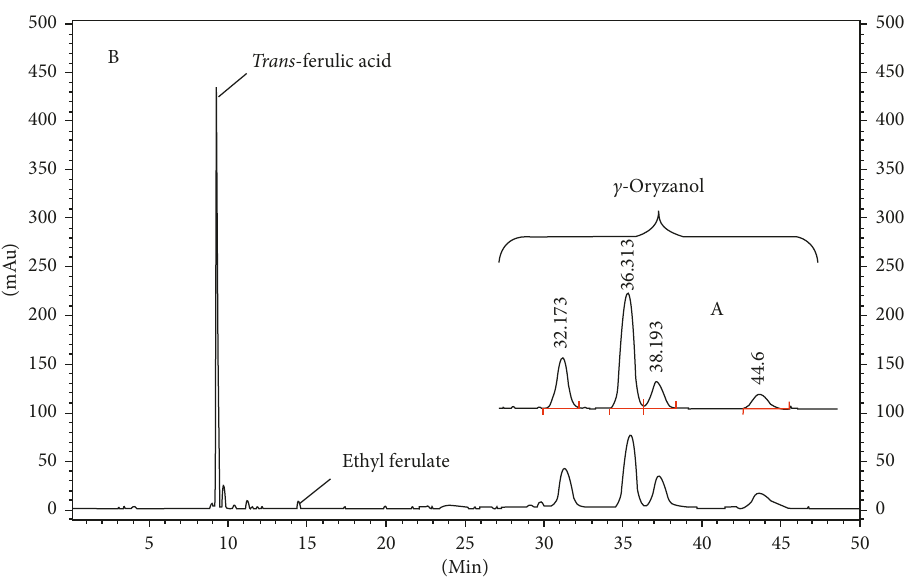
Figure 1: HPLC chromatogram (UV